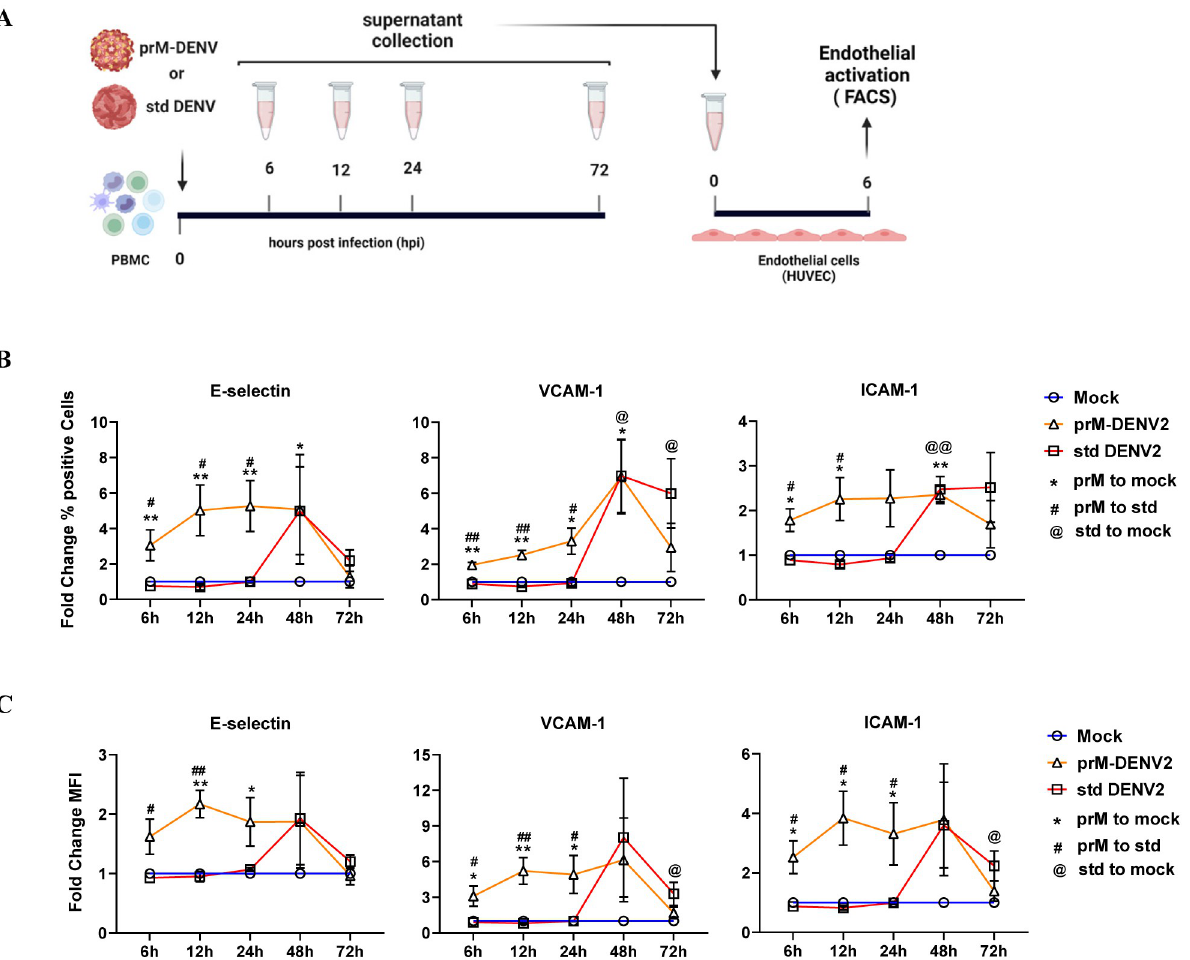
Fig 1. prM-DENV2 induces an early onset of soluble inflammatory responses. ( A ) Experimental scheme: HUVEC were incubated with cell-free supernatants harvested at indicated time points from hPBMCs (n = 3, three different donors) exposed to prM-DENV2 (MOG 300), std DENV2 (MOG300) or mock treatment. Surface expression of E-selectin, VCAM-1 and ICAM-1 on HUVEC was determined by flow cytometry and represented as ( B ) percentage of positive cells and ( C ) MFI normalized to relative mock values. Data represents the mean ± SEM. P values were obtained by unpaired one-tailed t test ( � /#/@ P < 0.05; �� /##/@@ P < 0.01). ( A ) Figure created with BioRender.com.